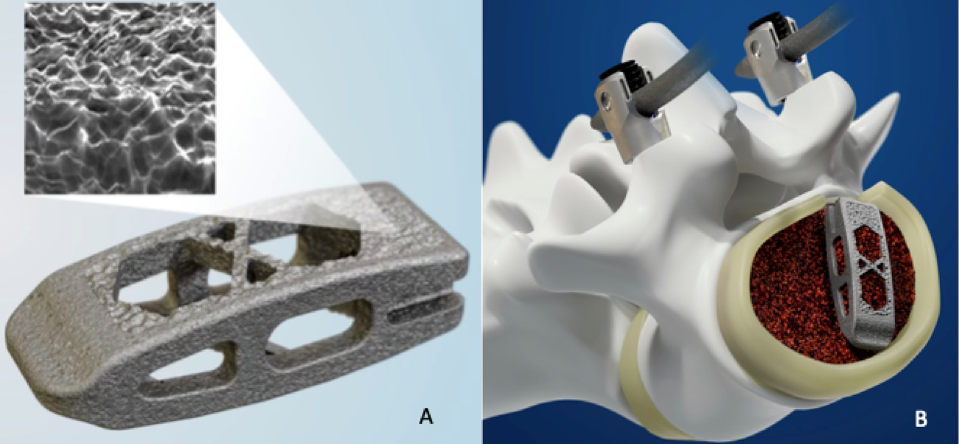
Figure 4. ( A ) 3D printed titanium cage ( B ) with interbody placement. Printed with permission from Medtronic PLC (Minneapolis, MN,